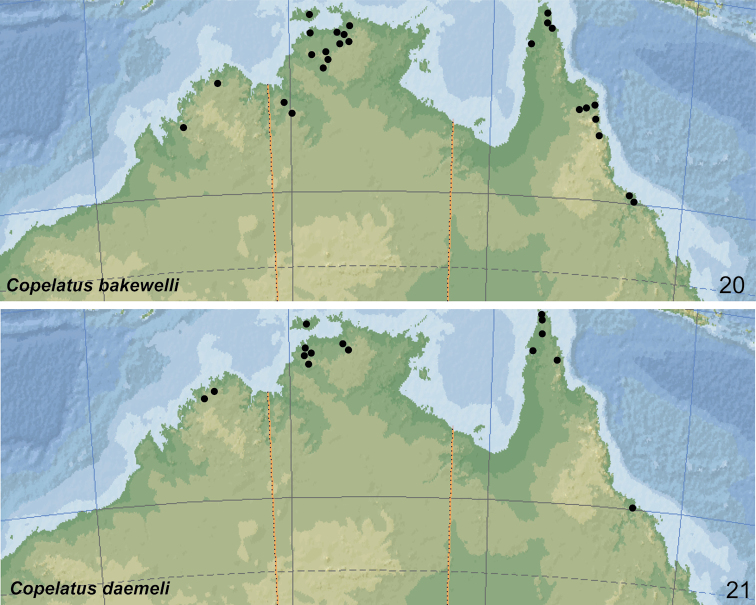
Distribution of 20Copelatus
bakewelli21C.
daemeli.